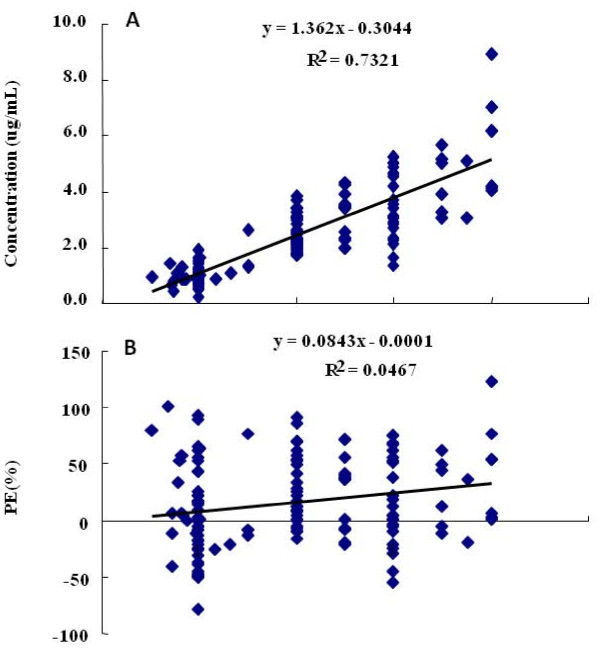
Predicted concentrations of Propofol in 3<year < 8 by SLOG TCI-III (Pediatric) system (Figure 3A), and performance error (PE%) against the calculated concentrations in 3<year < 8 by SLOG TCI-III (Pediatric) system (Figure 3B).